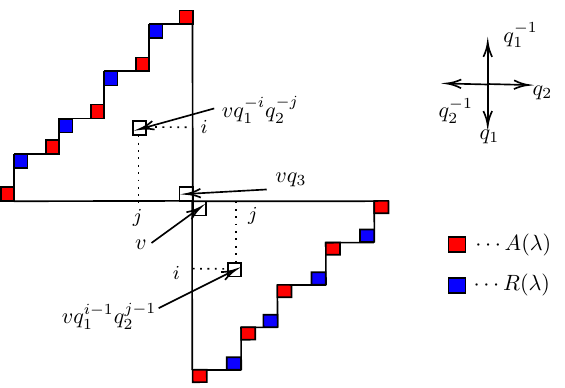
= , x ∈ λ , where χ (+) x x